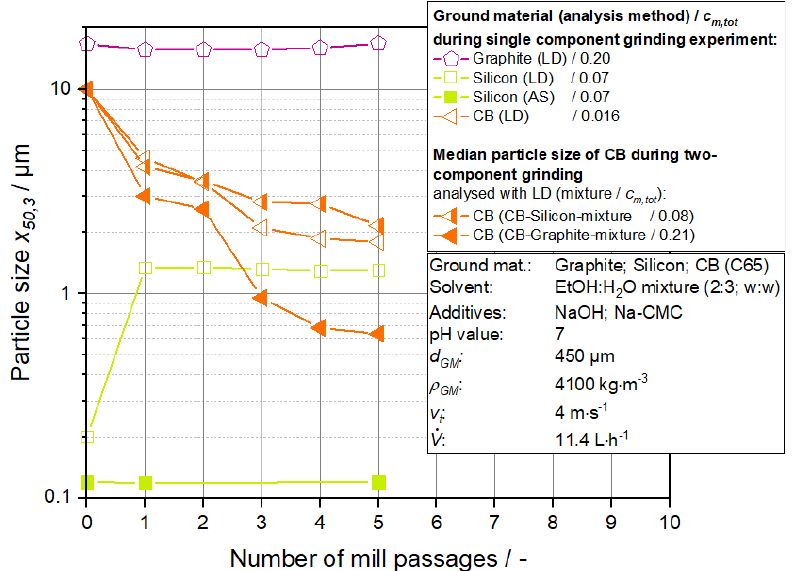
Figure 11. Median values of the three milled materials silicon, carbon black, and graphite during the processing of these individual materials as a function of the number of mill passages as well as for carbon black for the cases that it was processed together with silicon or graphite in a two-material mixture in each case.